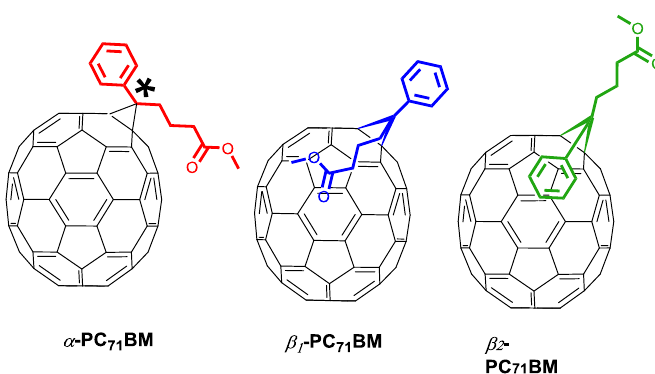
Figure 9. Different isomers of PC 71 BM. Adapted from reference [124].